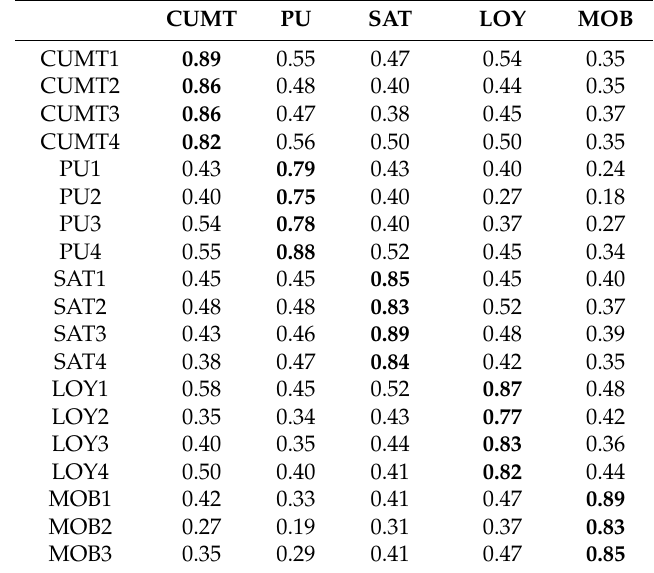
Table 4. Loadings and cross-loadings.